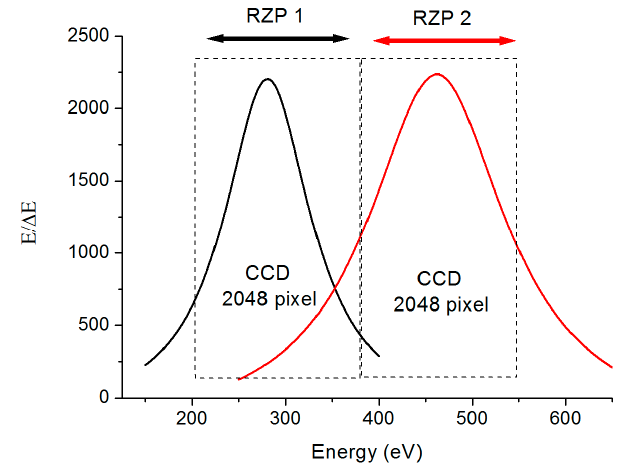
Figure 5. Energy resolving power E / ∆ E for RZP 1 (black) and RZP 2 (red) in the aperture of the CCD detector with 2048 pixels. Ray tracing [6] was used for the simulation, assuming an effective spatial resolution of 25 µ m for the detector.